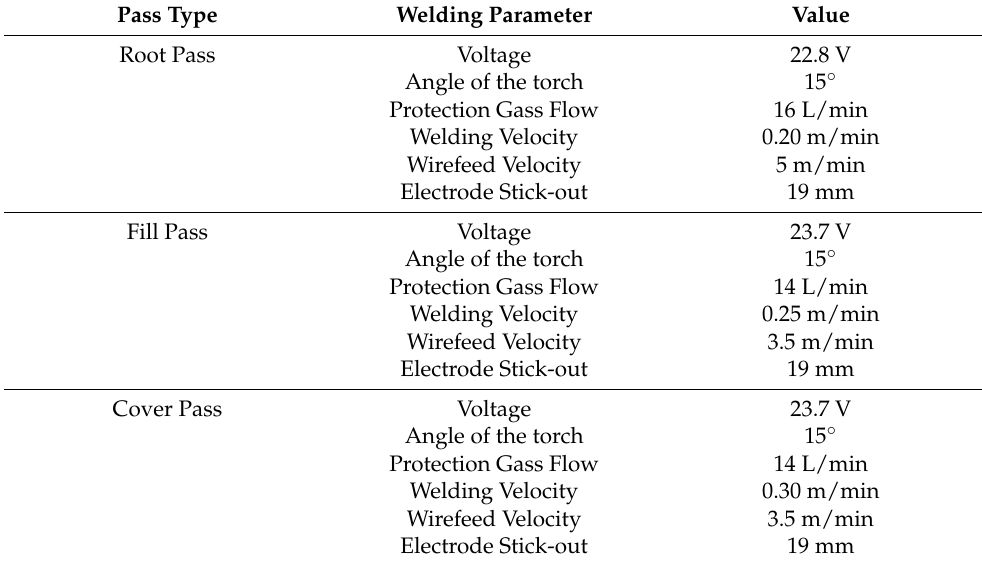
Table 2. Parameters used for multipass welding.